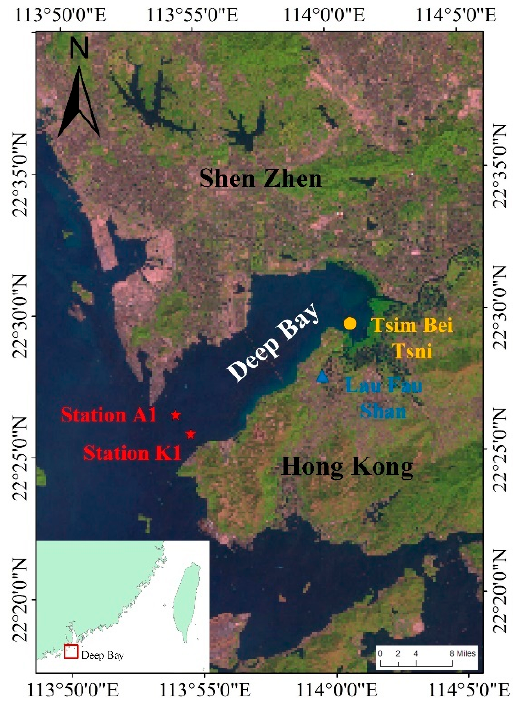
Figure 1. Location of Deep Bay, China, and in situ sites (A1 and K1, red stars), the tidal measuring station at Tsim Bei Tsui (yellow circle) and meteorological measuring station at Lau Fau Shan (blue triangle). The image is from Landsat/TM observation on 2 November 2009 (RGB = band 5, band 4, band 3).